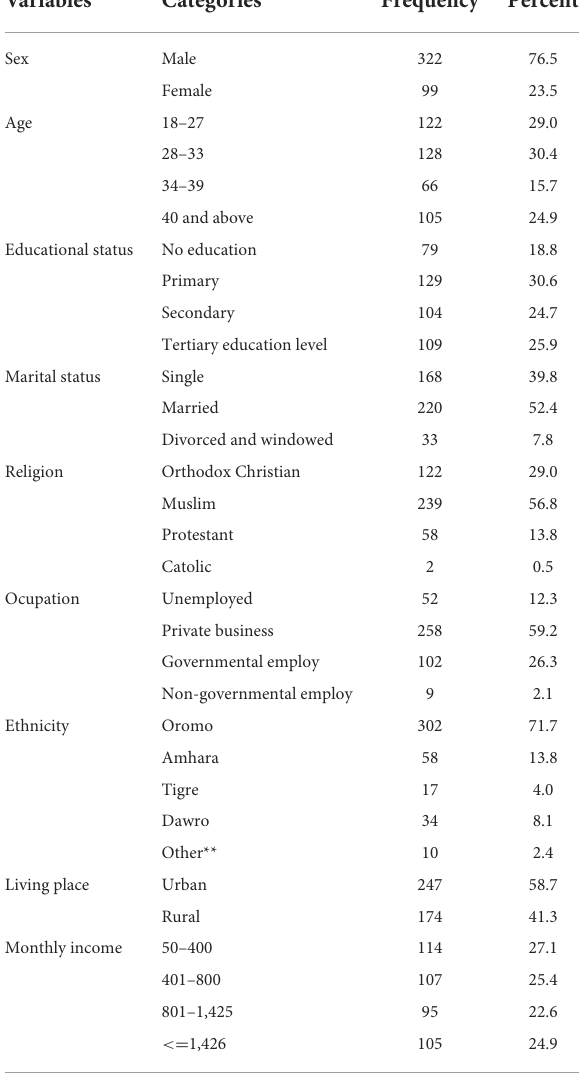
TABLE 1 Socio-demographic characteristics of respondents attending follow-up treatment at the University Medical Center Psychiatry Clinic, Jimma, southwest Ethiopia, 2022 ( N =